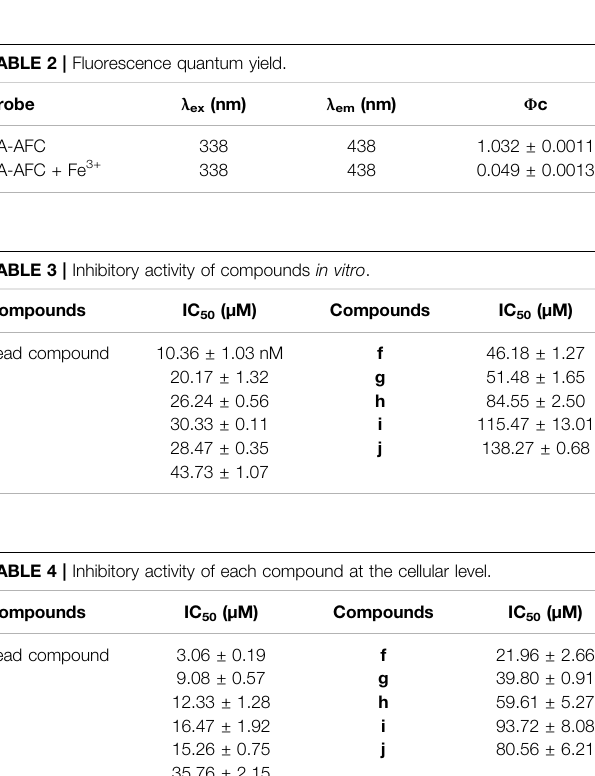
FIGURE5| FluorescenceimagingoflivingES-2-Fluccells:toprow,ES-2-FluccellsincubatedwiththeprobePA-AFC(20 μ M)for30 min: (A) bright- fi eld, (B) green channel; bottom row, ES-2-Fluc cells incubated with the probe PA-AFC (20 μ M) and Fe 3+ (1 mM) for 30 min: (C) bright- fi eld, (D) green channel.